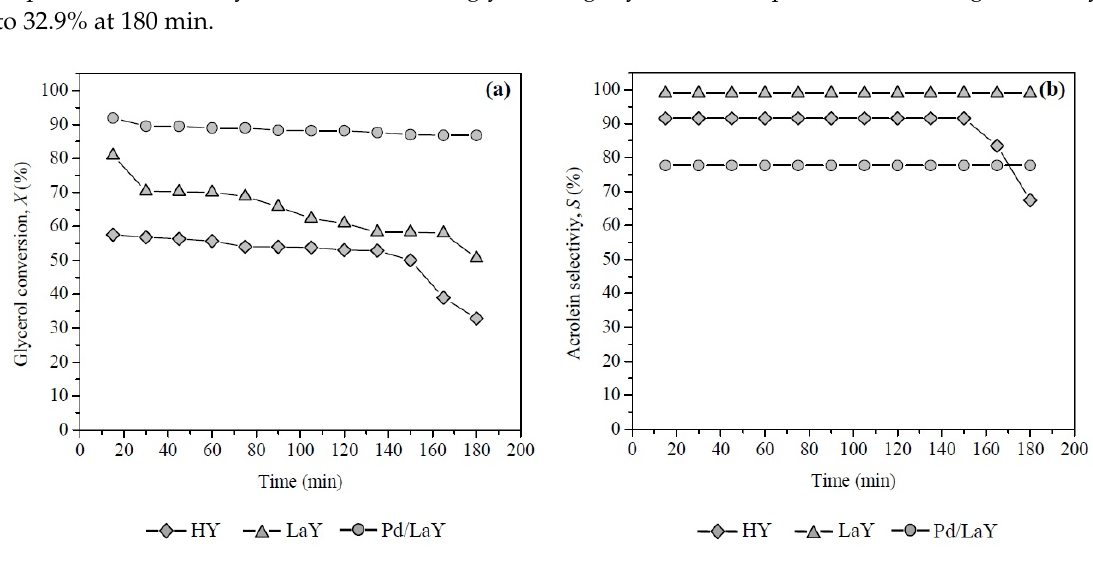
Figure 10. ( a ) Glycerol conversion and ( b ) acrolein selectivities of HY, LaY and Pd/LaY catalysts with time on stream at 548 K, 10 wt % glycerol, 0.3 g of catalyst, GHSV = 5933 h − 1 .